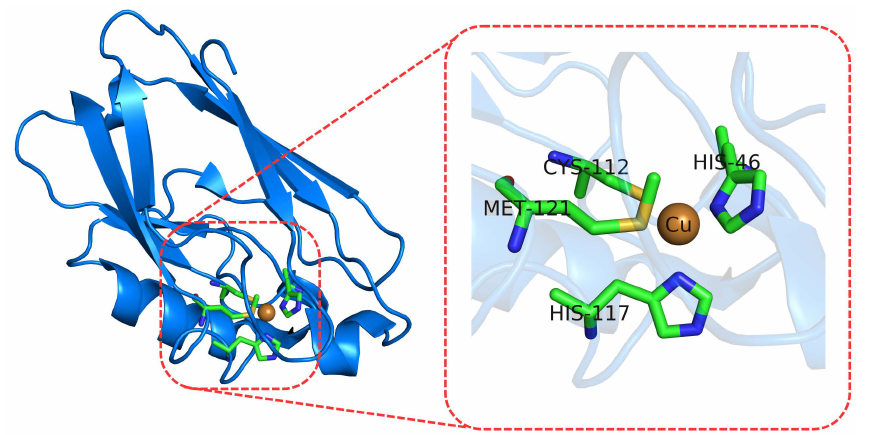
Figure 2. Cartoon representations of the Azurin protein ( left ) from Pseudomonas aeruginosa (PDB: 4AZU) and its copper binding site ( right